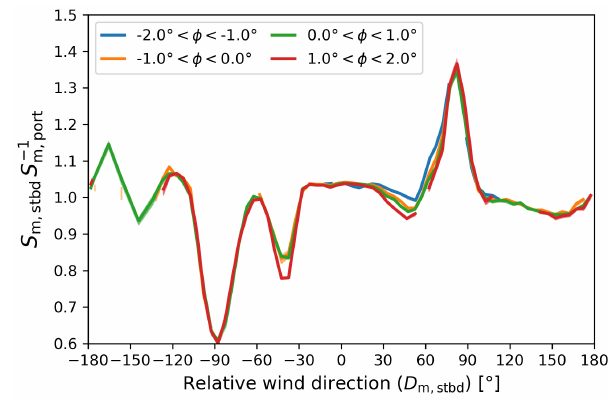
Figure A1. Ratio of the relative wind speed recorded by the star- board and port anemometers ( S m , stbd S − 1 m , port ) as a function of the relative wind direction recorded by the starboard anemometer. The ratios are computed for 1 ◦ intervals of the ship’s roll angle, which are provided in the legend.